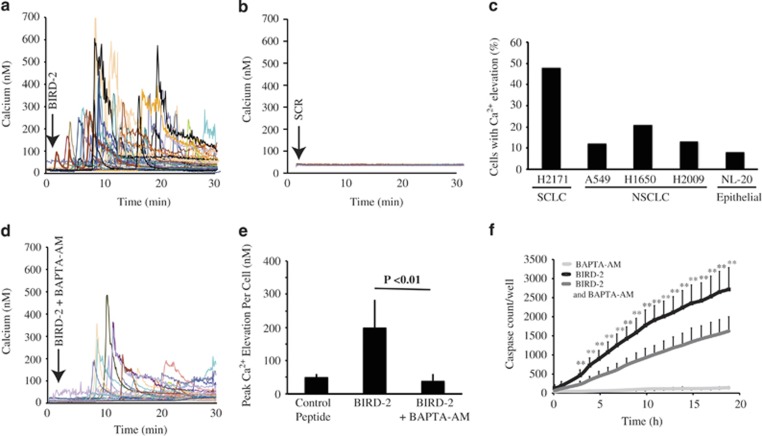
BIRD-2-induced Ca2+ elevation and Ca2+-mediated caspase activation. (a) Shown are continuous single-cell recordings of cytoplasmic Ca2+ by digital imaging, performed simultaneously in 65 H2171 SCLC cells following addition of 10 μM BIRD-2 (arrow). Traces represent Ca2+ levels in individual cells. (b) Same as panel (a) except in Scr-treated H2171cells. (c) Bar graph represents the percentage of SCLC, NSCLC, and normal lung epithelial cell lines responding to BIRD-2 with a significant elevation of cytoplasmic Ca2+ above basal Ca2+ levels. Cytoplasmic Ca2+ was measured as in panel (a). This figure summarizes a single experiment analyzing >80 cells in each cell line; shown is the average peak cytoplasmic Ca2+ elevation in each cell line within 30 min following addition of 5 μM BIRD-2. (d) Cytoplasmic Ca2+ was recorded as in panel (a) except that H2171 cells were pretreated 1 h before adding 10 μM BIRD-2 with 5 μM BAPTA-AM to chelate intracellular Ca2+ and thus block cytoplasmic Ca2+ elevation. (e) Shown is a bar graph representing the peak cytoplasmic Ca2+ elevation (mean±S.D., three experiments) induced by 10 μM BIRD-2 treatment, with or without 10 μM BAPTA-AM pretreatment. Results indicate that BAPTA-AM pretreatment inhibits BIRD-2-induced Ca2+ elevation. (f) BAPTA-AM pretreatment decreases BIRD-2-mediated caspase 3/7 induction, measured by IncuCyteZOOM as in Figure 3c. Experiments in panels d–f were performed at least three times, using 2–5 μM BAPTA-AM and 15–20 μM BIRD-2. Error bars in panel (e) represent mean±S.D., N=85 cells. **P<0.01